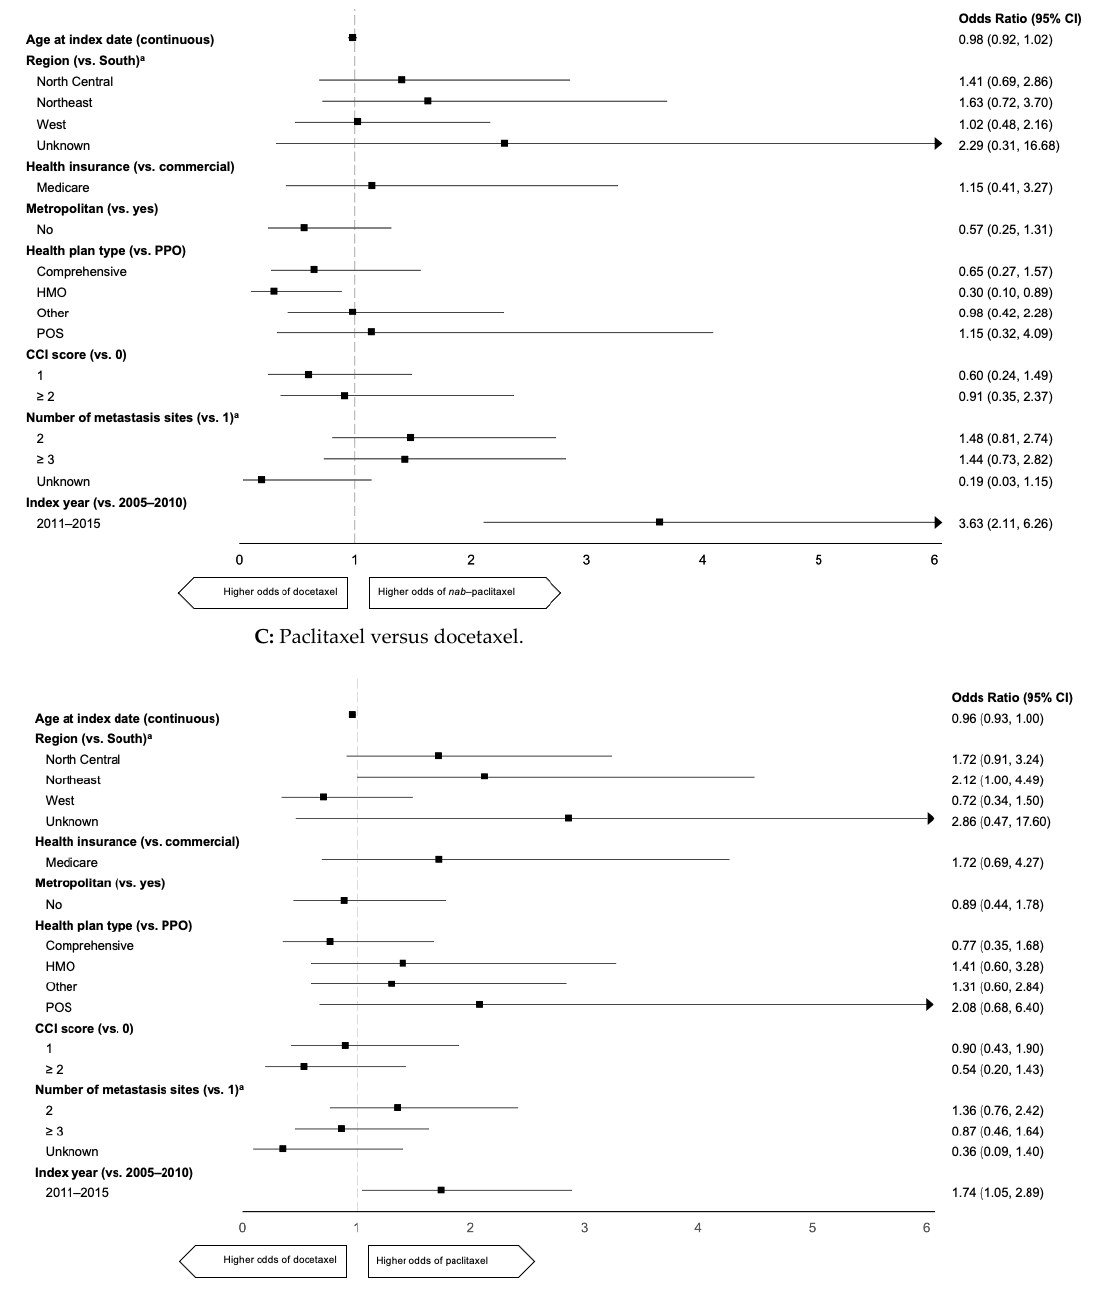
Figure 3. Predictors of specific taxanes used in 1L mTNBC. ( A ) nab -Paclitaxel versus paclitaxel. 1L: first line, CCI: Charlson